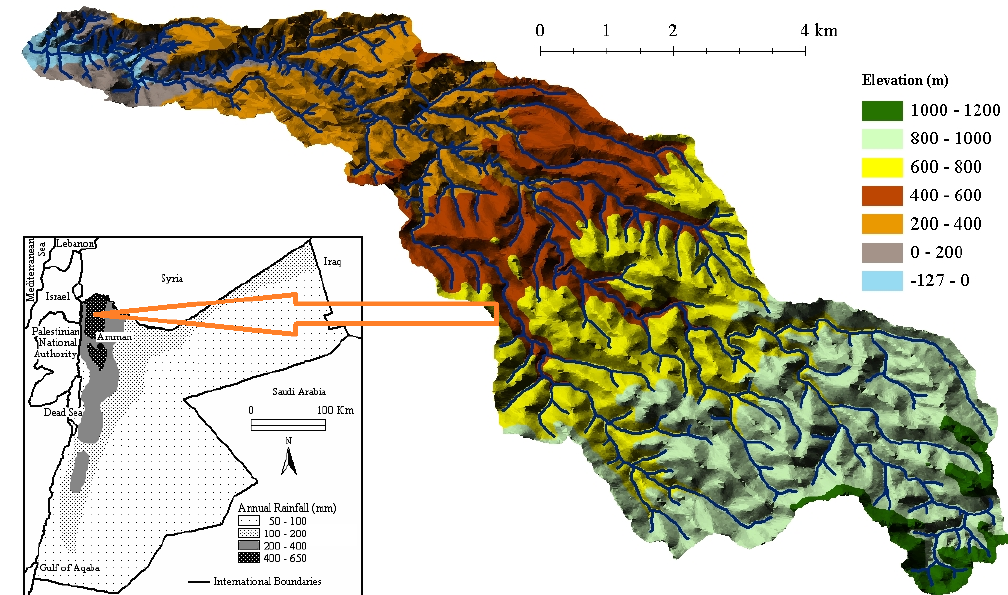
Figure 1. Location, boundary and elevations within the Wadi Ziqlab